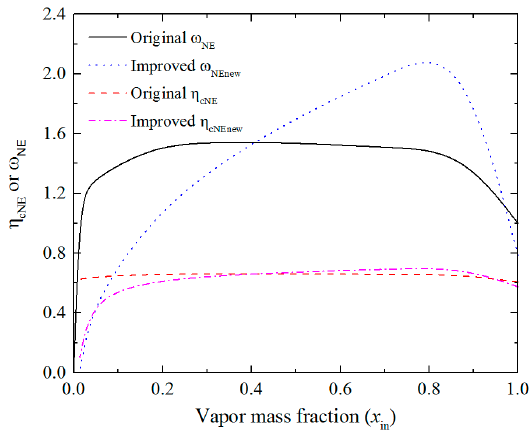
Figure 2. Comparison of original ω NE , η cNE and improved ω NEnew , η cNEnew , where ω NE and η cNE are calculated from the original HNE-DS model, and ω NEnew and η cNEnew are calculated from the improved HNE-DS model.